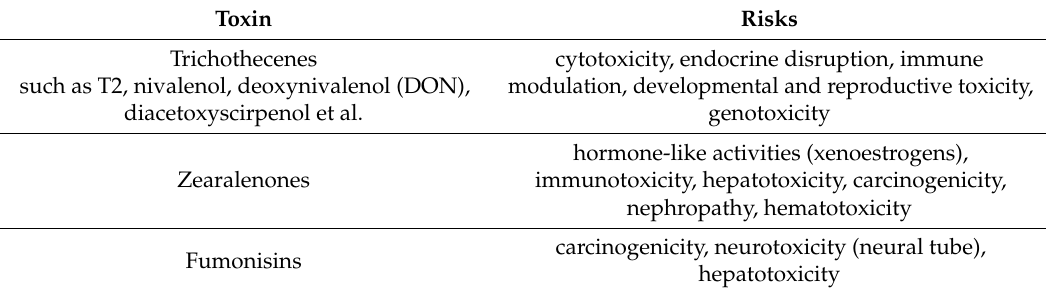
Table 2. Some characteristics of the most important fusarial mycotoxins according to [12].